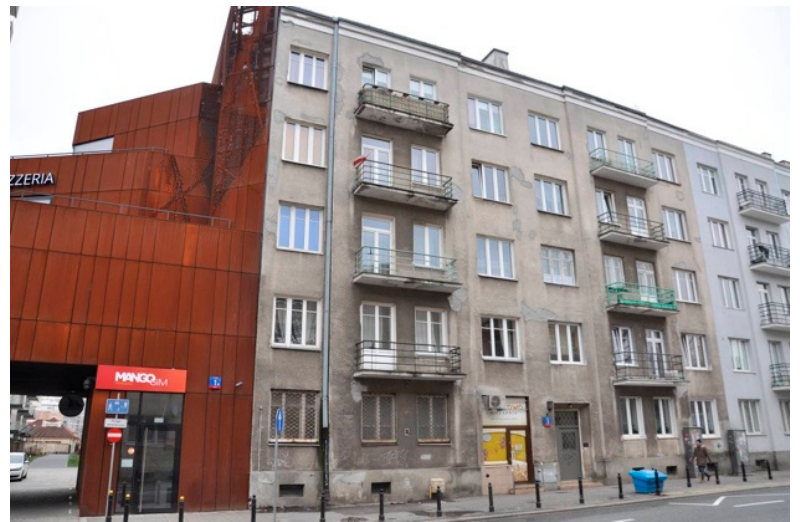
Figure 3. Building at 3 Ludna Street; on the left, part of the directly adjacent building D is visible. The shape of the building resembles a rectangle with the following dimensions: length—25.80 m (dimension parallel to the axis of Ludna Street, see Figure 1); width—14.32 m. The height of the building, measured from the ground level to the ridgepole, is 19 m. The external structural walls are made of ceramic brick, full thickness, with 2 bricks used on the basement and ground floor levels and 1 brick used on the fourth floor and attic